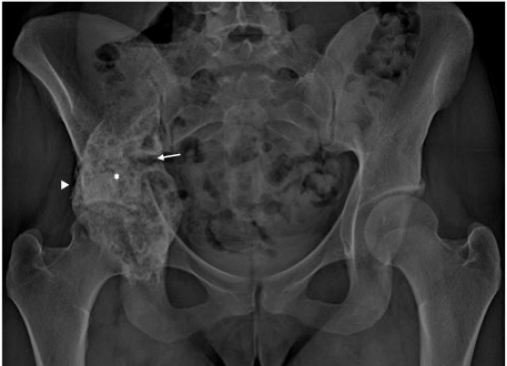
Figure 2. Plain radiography, frontal projection. Lobulated, mostly osteolytic, expansive, bone mass centered on the right acetabular region (star). Small areas of bone cortex interruption in the medial part (arrow). Minimal periosteal reaction in the lateral aspect (arrowhead).